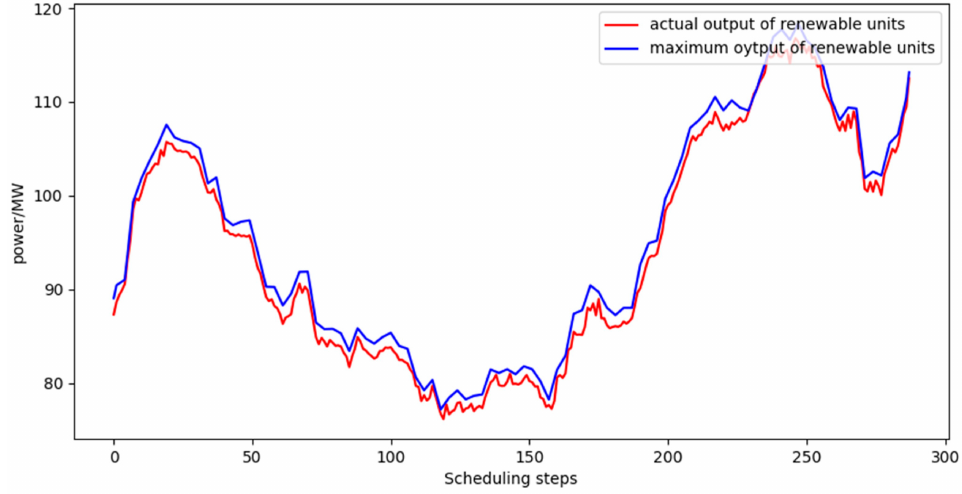
Figure 7. The scheduling period with a small proportion of the maximum renewable energy output.